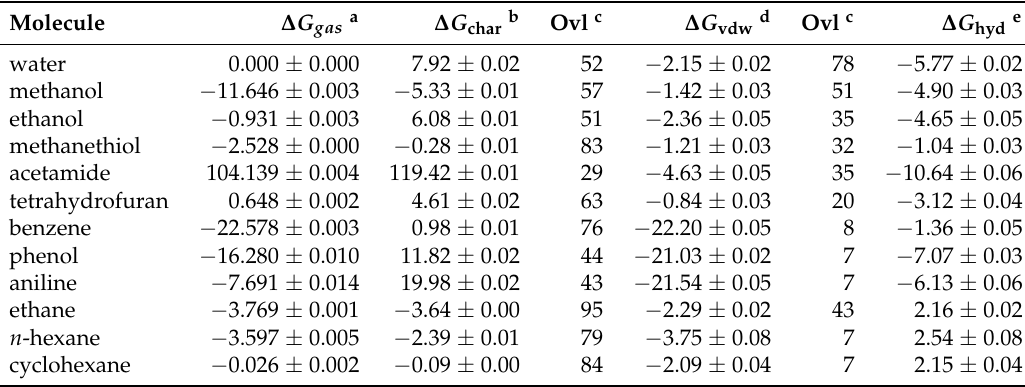
Table A2. Free energy differences of all substeps of the hydration free energy calculations with the CHARMM Drude force field in